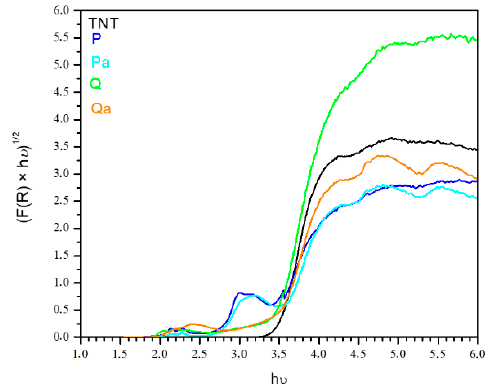
Figure 4. Absorption spectra for the evaluation of band gap energy for photocatalysts analyzed.